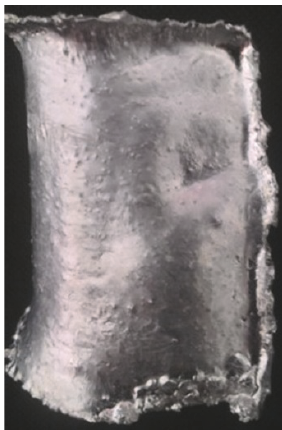
Figure 8: Photograph of zinc coat obtained under the pressure drop 𝑃 /𝑃 𝑏 0 = 1.68.